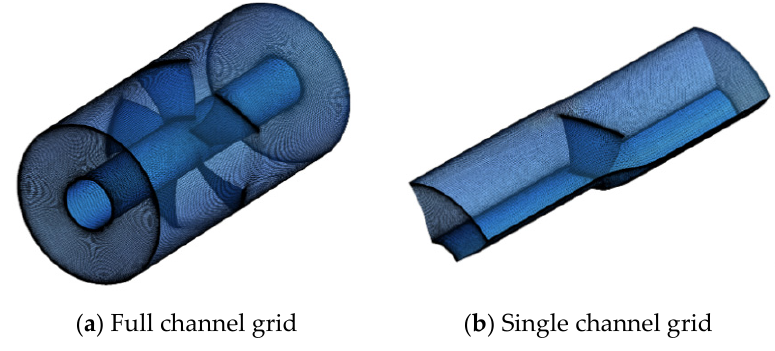
Figure 12. Grid of the axial fan.